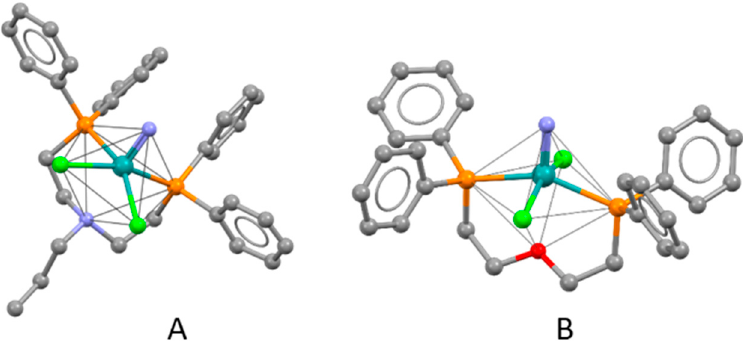
Figure 8. Pseudo- oc [TcNCl 2 (PXP)] species. ( A ) [TcNCl 2 (PN(Pr)P)]; ( B ) [TcNCl 2 (POP)].